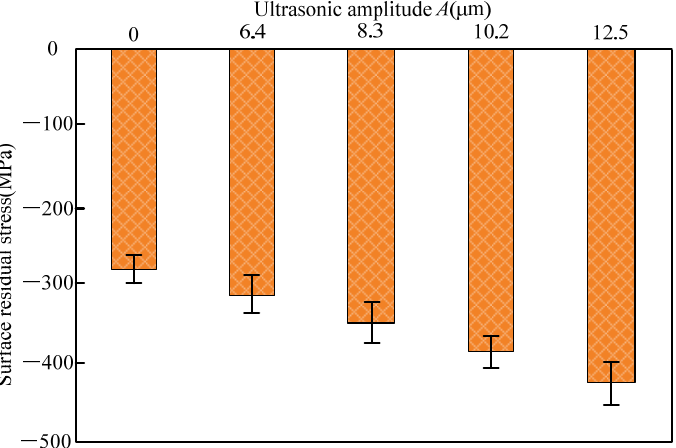
Figure 16. Variation of surface residual stress with ultrasonic